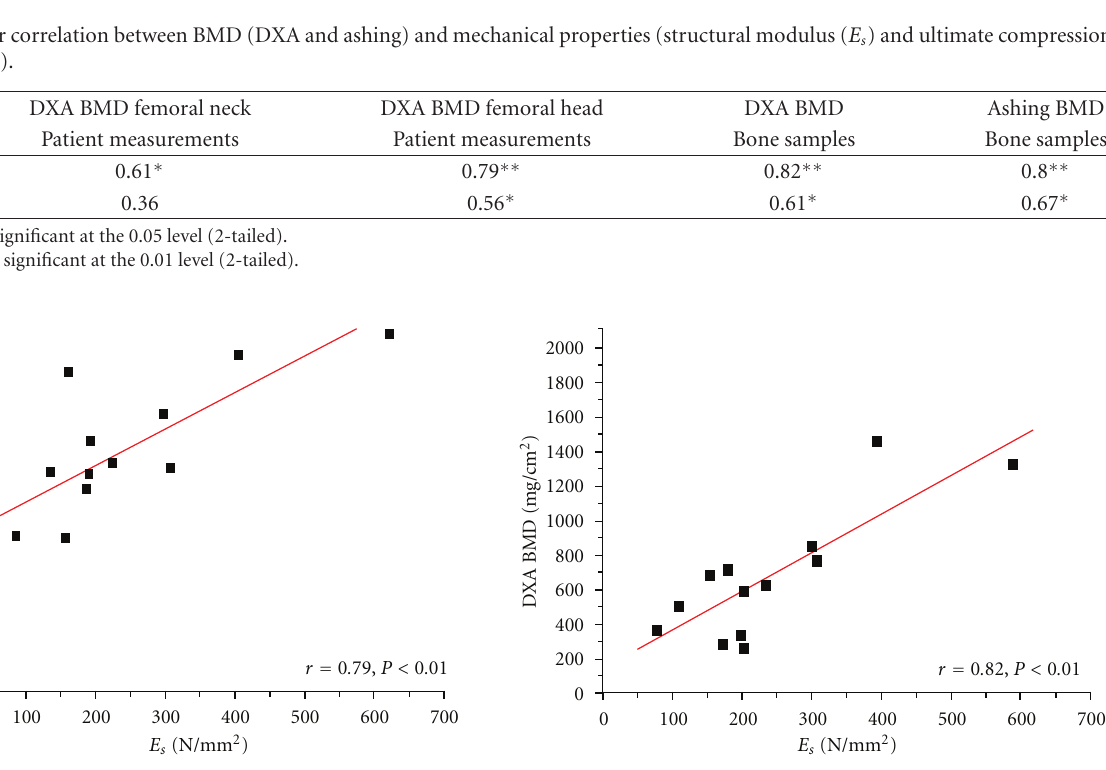
Figure 3: Linear correlation of structural modulus ( E s ) versus DXA BMD on femoral head (patient measurements).